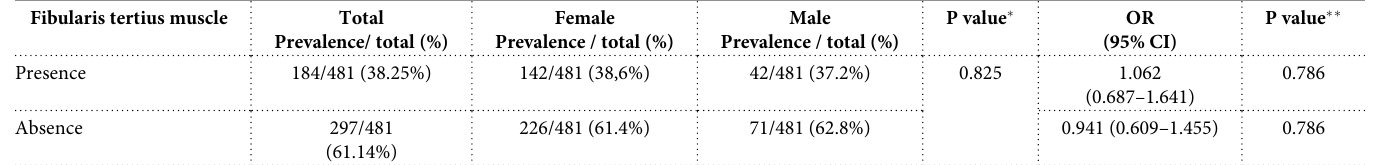
Table 2. Comparison of the presence and absence of the fibularis tertius muscle in males and females in a population in Spain. Fibularis tertius